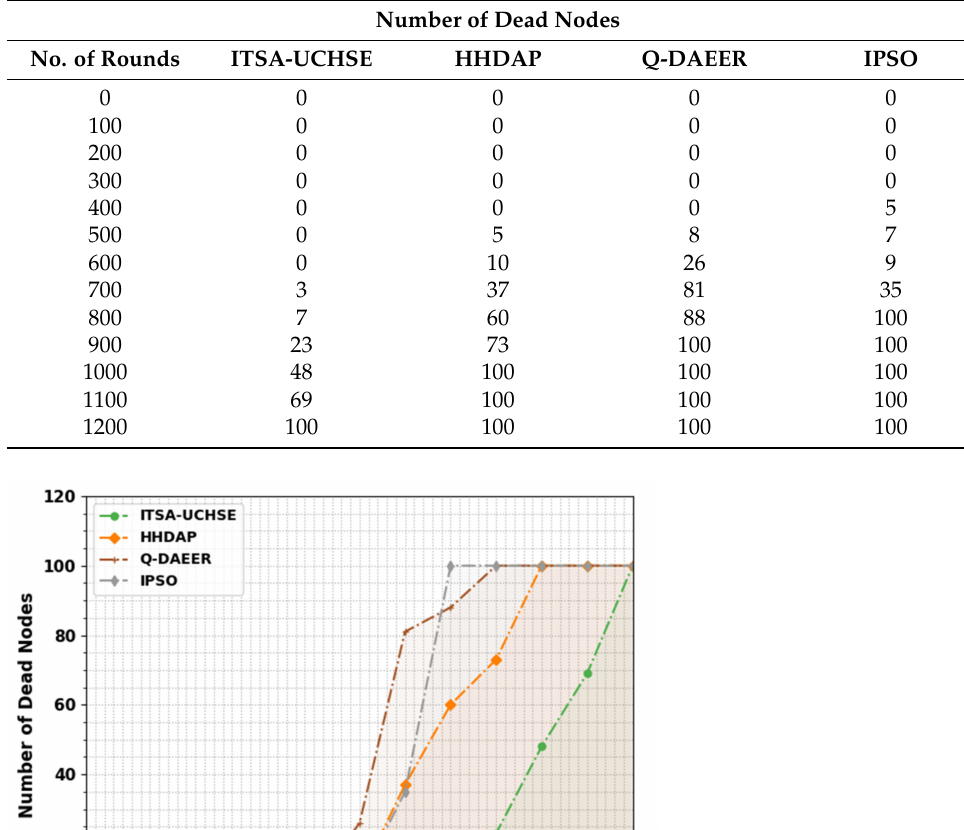
Figure 3. NOAN analysis of ITSA-UCHSE system under different rounds. Table 3. NODN analysis of ITSA-UCHSE system with current methods under different rounds.